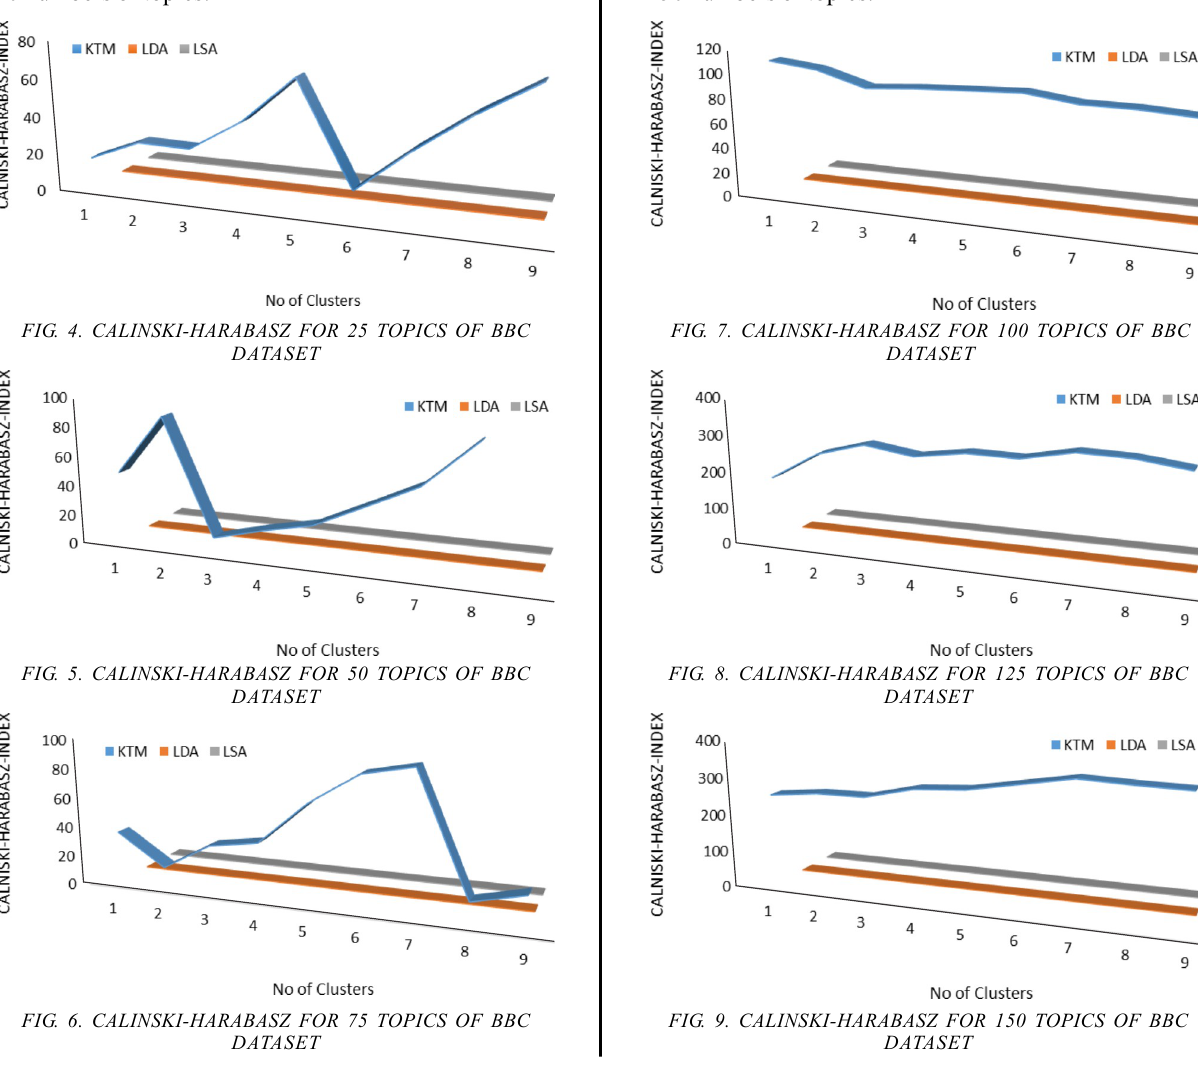
FIG. 7. CALINSKI-HARABASZ FOR 100 TOPICS OF BBC DATASET